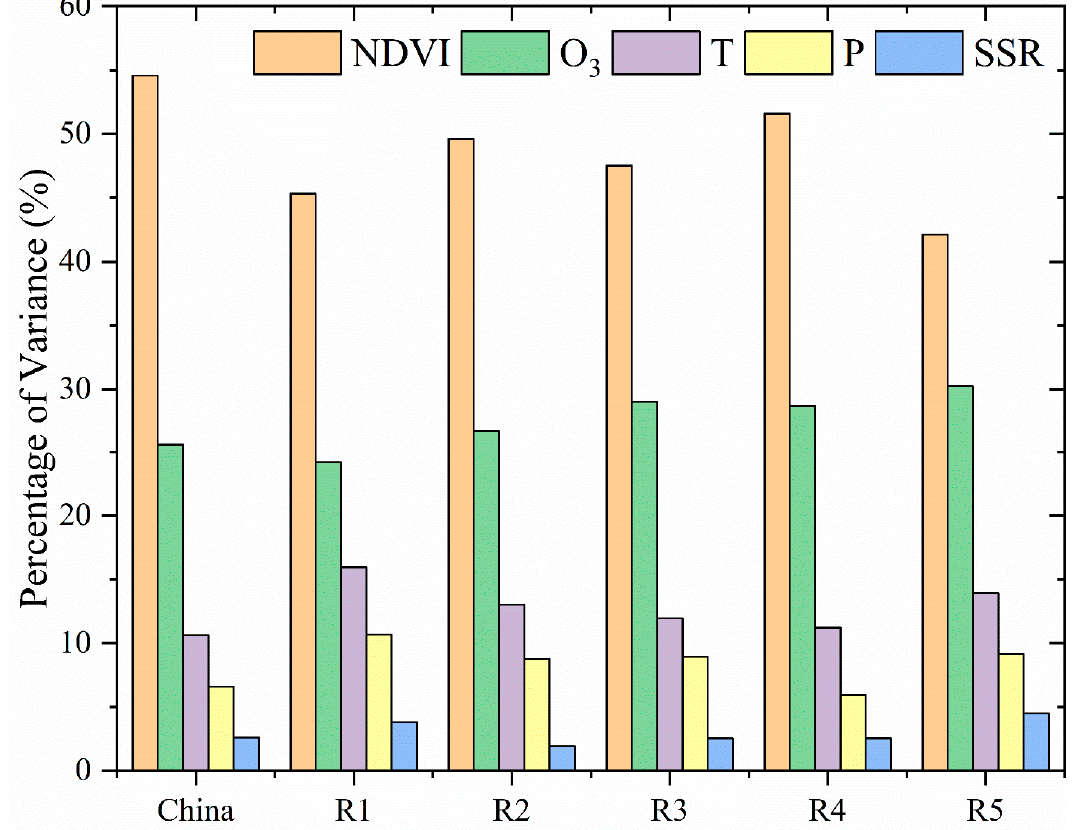
Figure 7. Comparison of the percentage of variance of NDVI, OMR and meteorological elements. Table 2. Correlation coefficients between NDVI and OMR and meteorological elements.